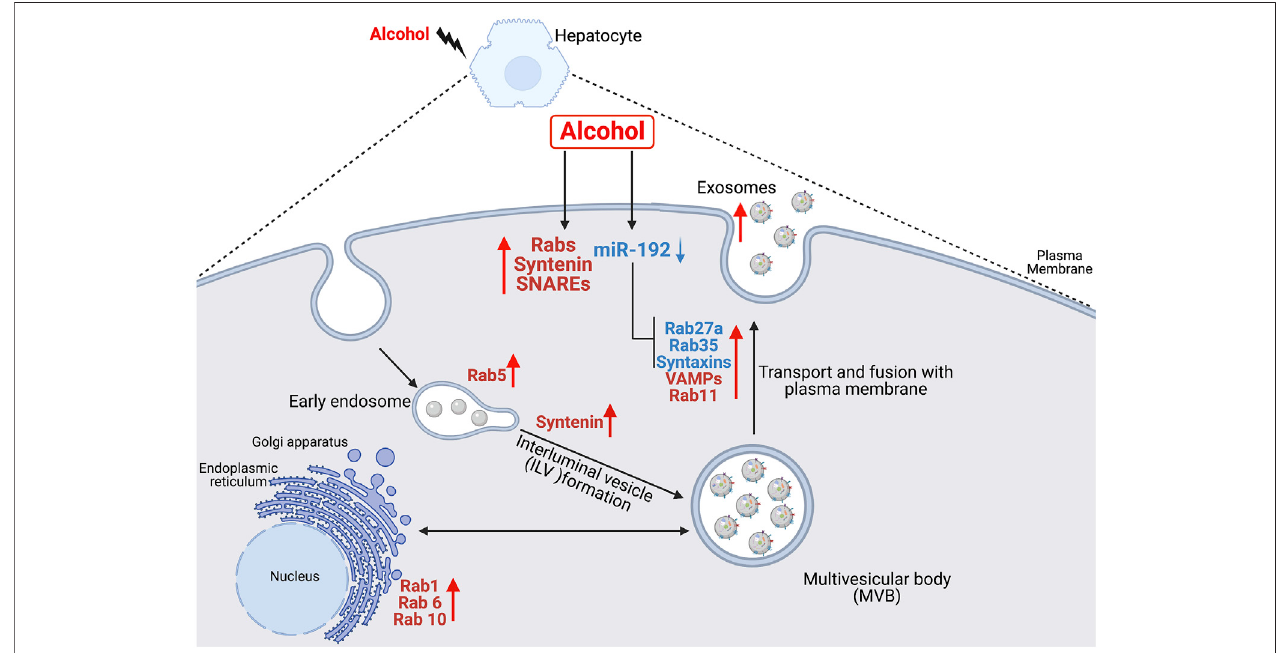
FIGURE 5 | Schematic representation of the effect of alcohol on exosome biogenesis and secretion in human hepatocytes. Alcohol modulates the expression of various Rabs, syntenin, VAMPs and syntaxins directly or partly via miR-192 in hepatocytes. Alcohol-induced decrease in miR-192 results in increase in miR-192 target genes (Rab27a, Rab35, syntaxin7 and syntaxin16) and a concurrent induction in exosome secretion.